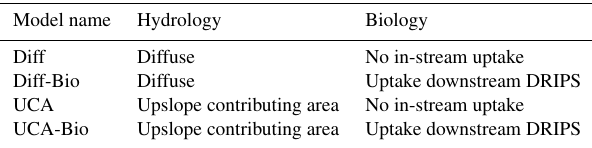
Table 1. Overview of the different model assumptions. The first column indicates the model name. The second column indicates whether streamflow is represented as a uniform diffuse rate along the reach or distributed based on upslope contributing area. The third column indicates whether in-stream uptake of dissolved or- ganic carbon (DOC) by biota is